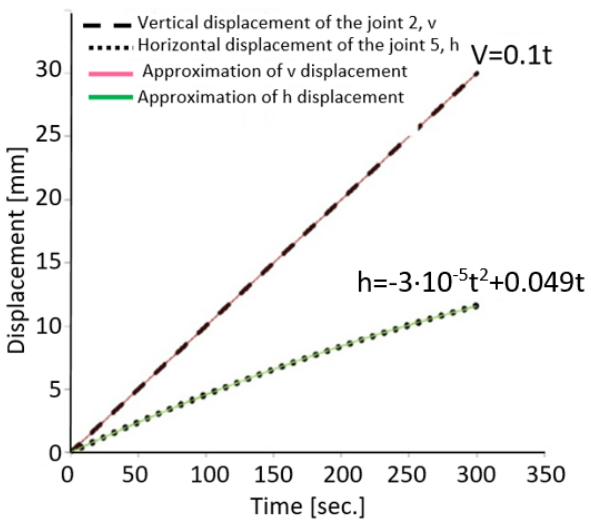
Figure 7. Displacement diagram.